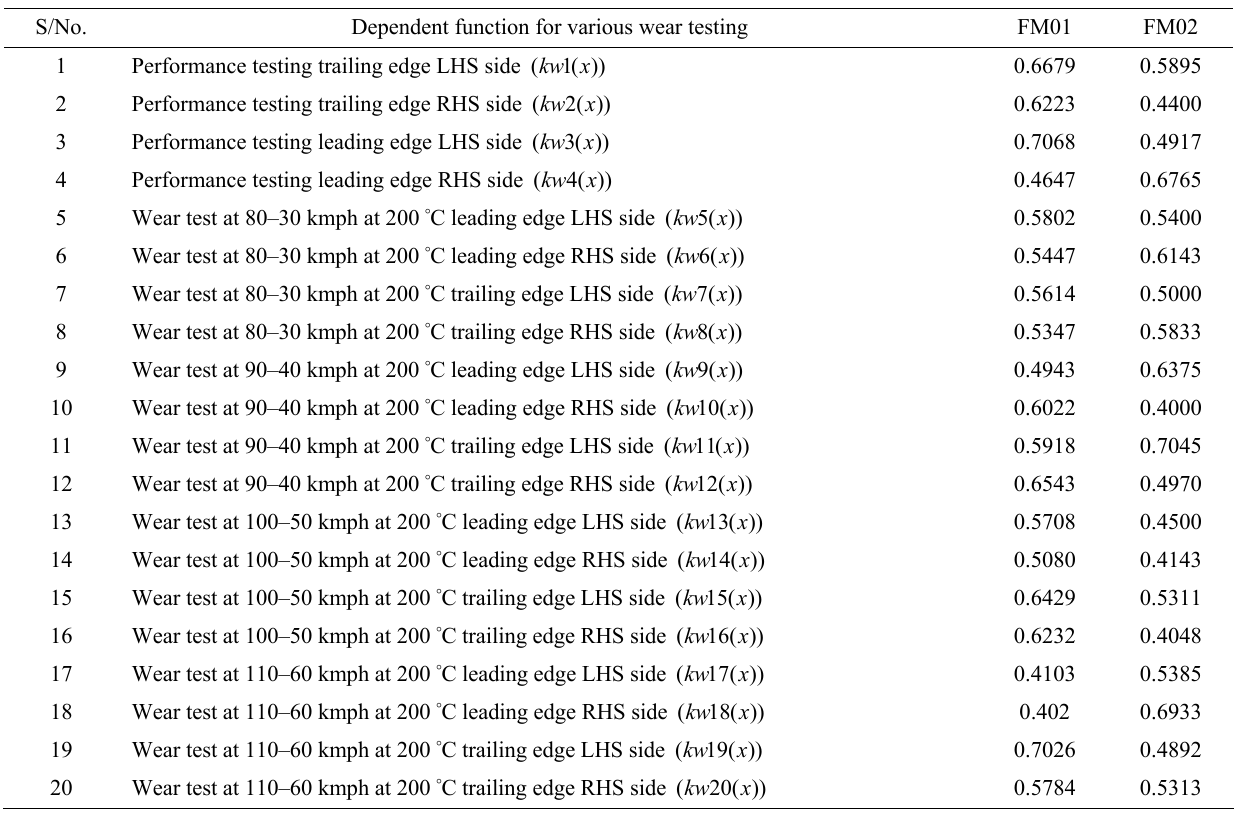
Table 6 Results of extensive evaluation of developed composites based on various wear tests.